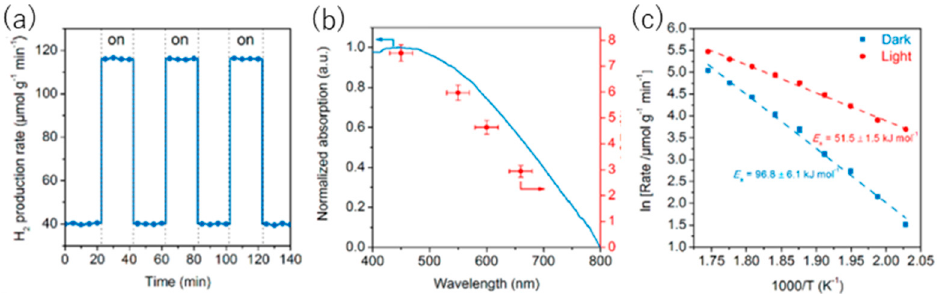
Figure 54. ( a ) Production rate of H 2 with and without visible light. ( b ) Action spectrum and UV-vis spectrum of Rh/TiO 2 . ( c ) Arrhenius plot constructed using the production rate. Reprinted with permission from [72]. Copyright (2018), American Chemical Society.